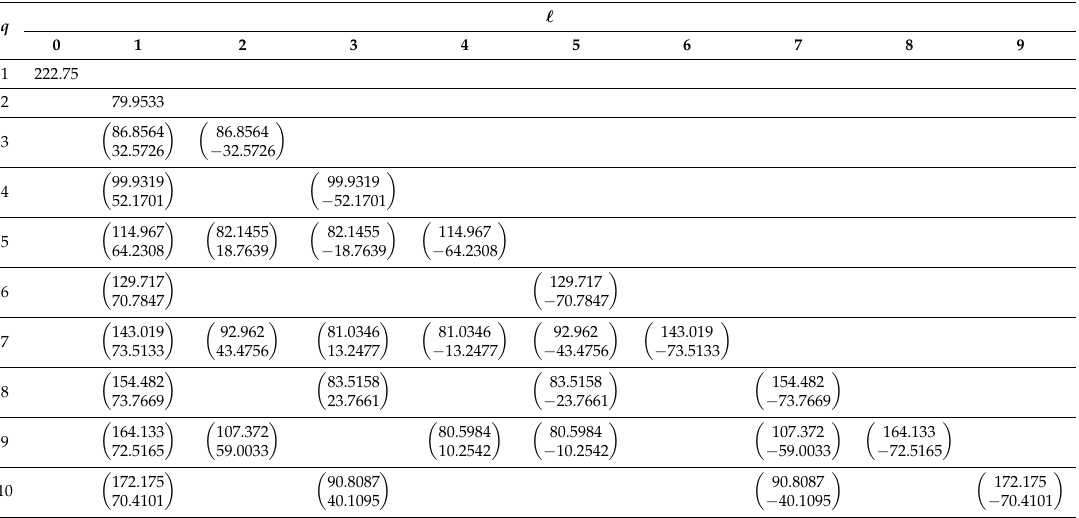
Table 2. Typical (cid:96) / q –bifurcation points λ (cid:96) , q for 1 ≤ q ≤ 10 along γ 3 ( t )